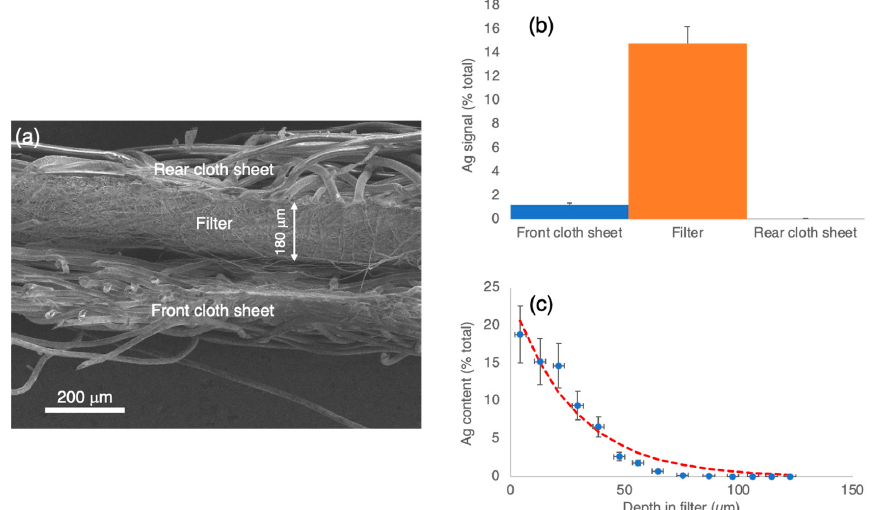
Figure 4. Distribution of Nanoparticles within the masks. ( a ) Low magnification SEM image of the mask cross section showing the three-layer structure with a front cloth sheet, the high-density weave filter and the rear cloth sheet. ( b ) EDX signal from Ag in a coated mask, expressed as a % signal from all elements, in the front sheet, filter and rear sheet. ( c ) EDX Ag signal as a function of depth in the filter of a coated mask fitted to an exponential curve (dashed line). It is evident that virtually no nanoparticles are transmitted through the mask.